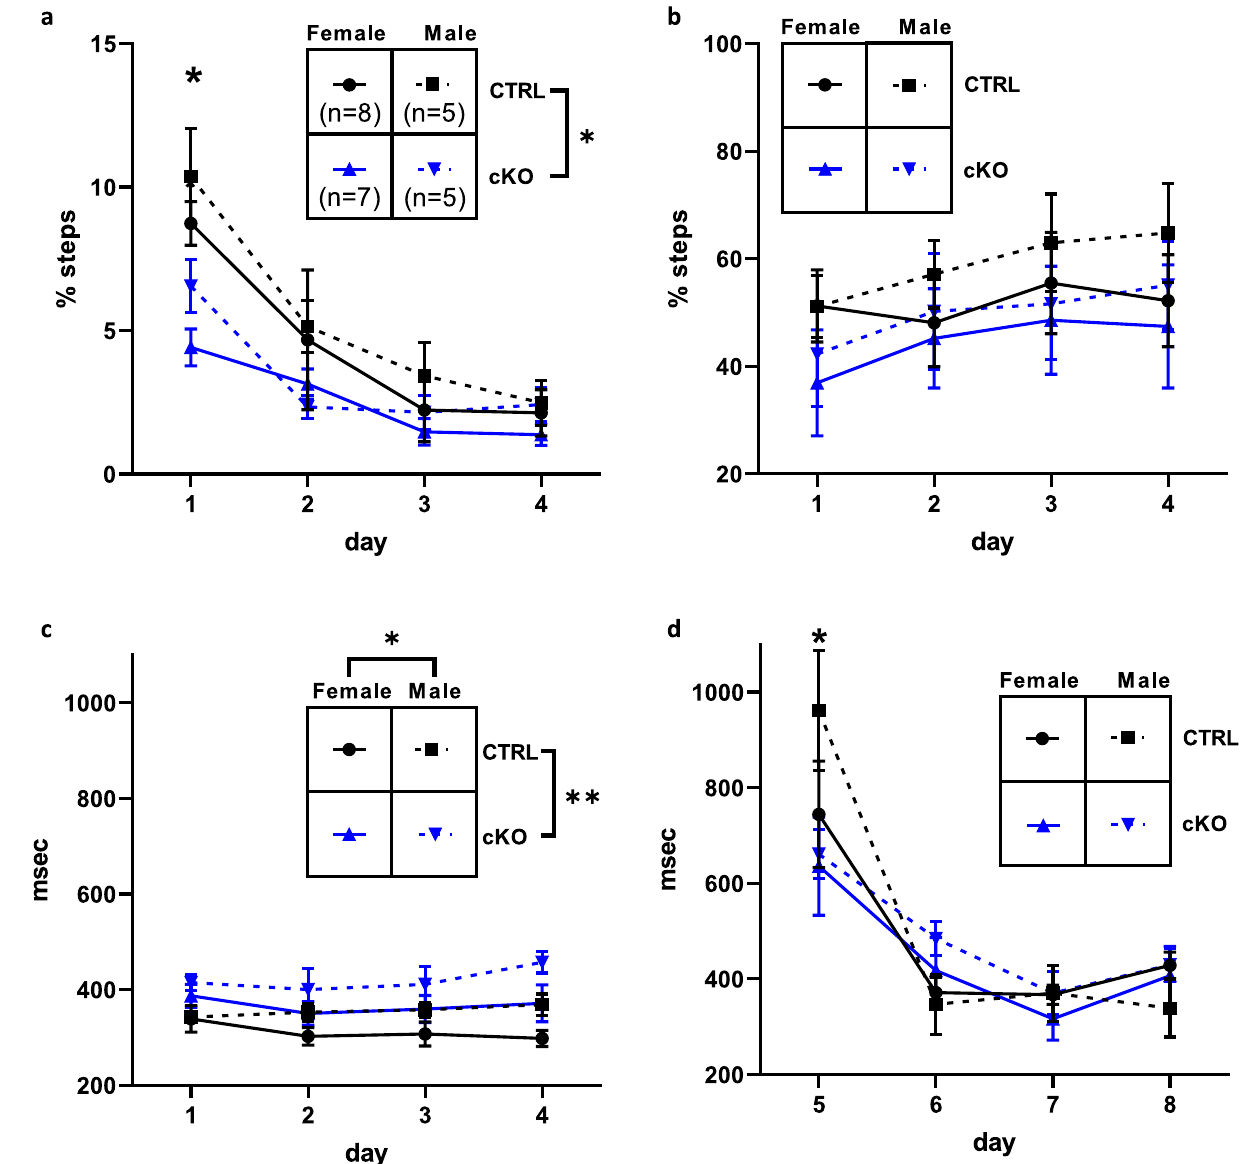
Figure 2. Ca V 1.2 cKO mice display slower gait but no deficit in cerebellar-dependent associative motor learning on the Erasmus Ladder task. ( a ) Neuronal Ca V 1.2 cKO mice had fewer missteps than CTRL littermates on day 1 which resolved on days 2–4. ( b ) We observed a main effect of day in the use of long steps, with no sex or genotype-dependent effects. Therefore, on average all groups use more long steps over the course of training, representing normal gait adaptation. ( c ) Neuronal Ca V 1.2 cKO mice had a longer average step time compared to CTRL littermates. Males also had a longer average step time compared to females. ( d ) All groups learn to jump over a displaced peg in response to a tone cue, shown as a decrease in step time between days 5 and days 6–8. Post hoc testing revealed that CTRL mice had longer post-perturbation step times on day 5 compared to cKO mice, but this was not observed on days 6–8, suggesting that all groups successfully learn to associate the tone with the displaced peg, representative of cerebellum-dependent associative learning. No sex-dependent effects were detected. Data are expressed as mean ± s.e.m, using ErasmusLadder 2.0.214, www. noldus. com/ erasm uslad